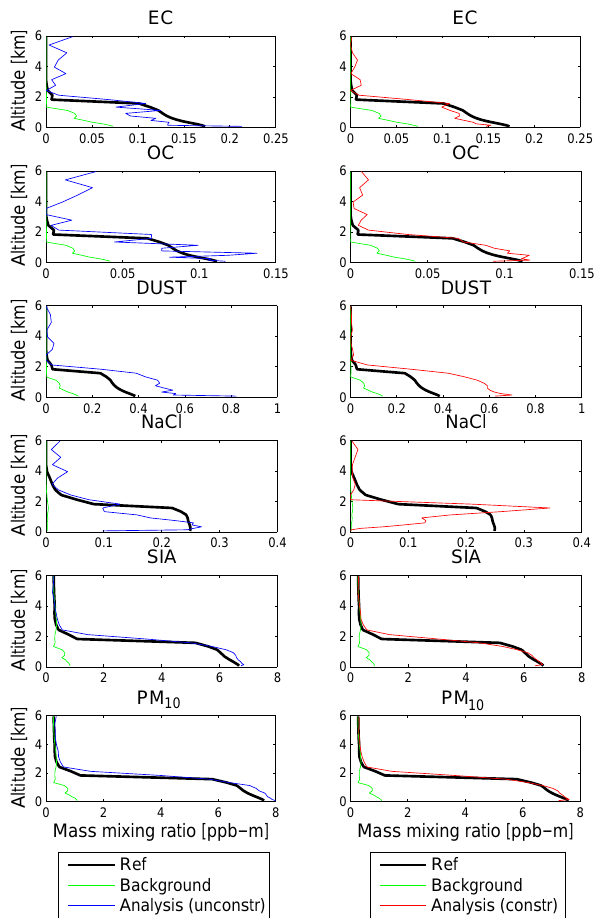
Figure 2. As Fig. 1, but for the total mass mixing ratio (summed over all size bins). The components are (from top to bottom): EC, OC, mineral dust, sea salt, secondary inorganic aerosols (sum of all sulfate, nitrate, and ammonium species), and PM 10 (sum of all aerosol components).